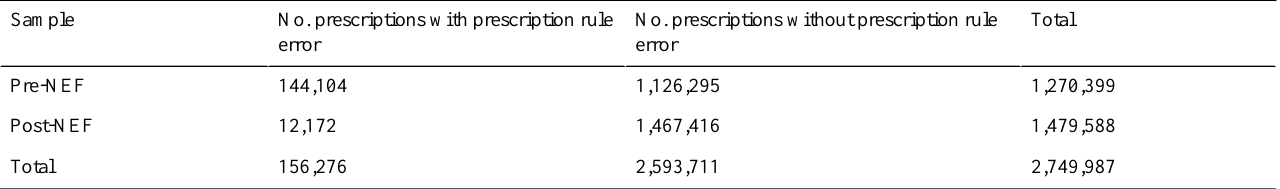
Table 13. Chi-square test of null-hypothesis with no significant improvement in prescription rule error.